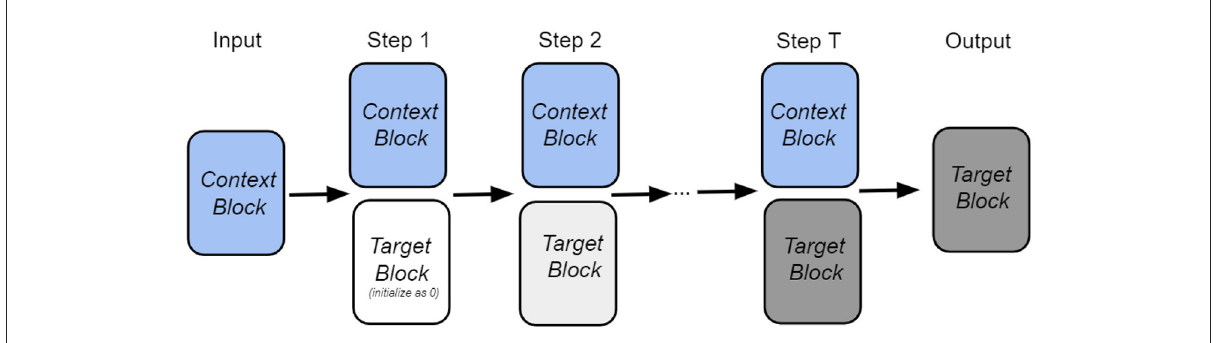
FIGURE1 The overall architecture of our iterative node retrieval